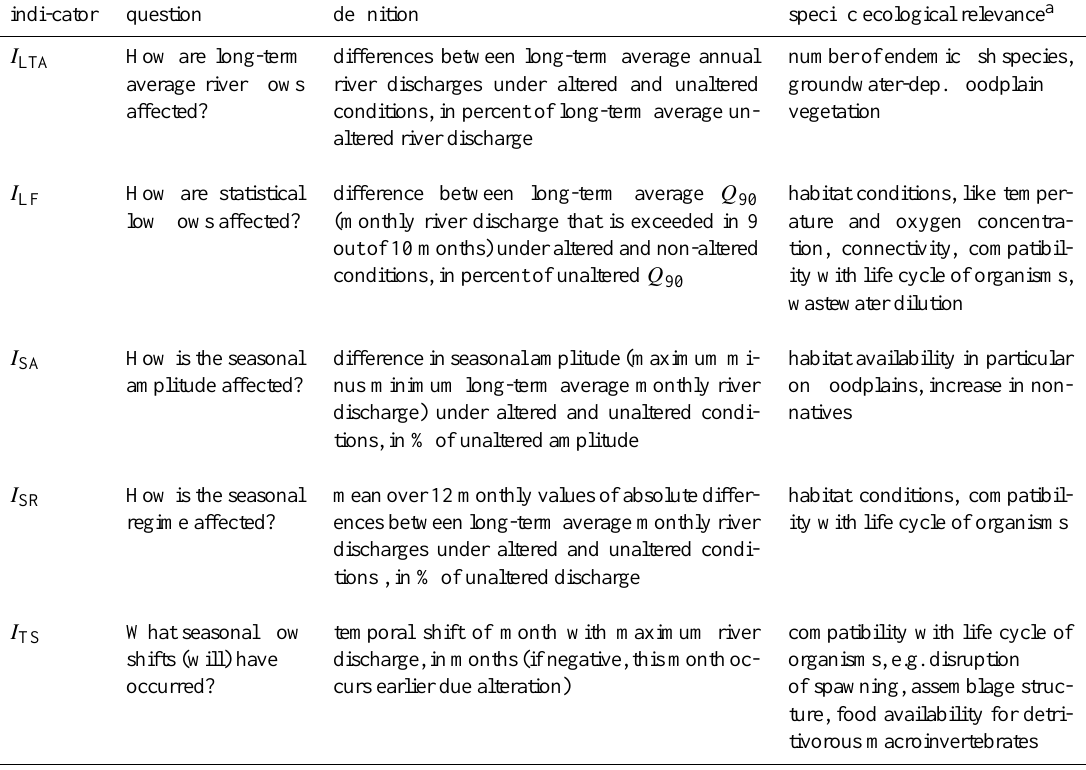
Table 1. Five ecologically relevant indicators of river flow alterations due to climate change or human water withdrawals and reservoirs. The term “altered” either refers to alterations due to climate change (CC-ANT), as compared to the climate of 1961–1990 (“unaltered”=ANT), or to alterations due to water withdrawals and dams, for 1961–1990 climate (ANT), as compared to naturalized conditions without any dams and withdrawals